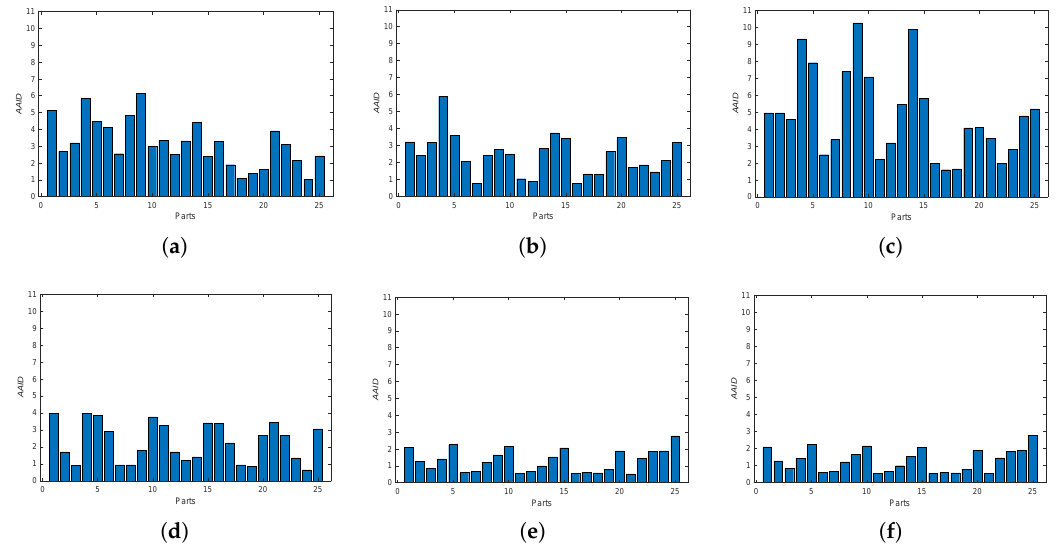
Figure 23. Spatial partition of the AAID evaluation for Lifting Body image. ( a ) MI. ( b ) PSNR. ( c ) NCC. ( d ) RANRESAC. ( e ) Proposed (Demp). ( f ) Proposed